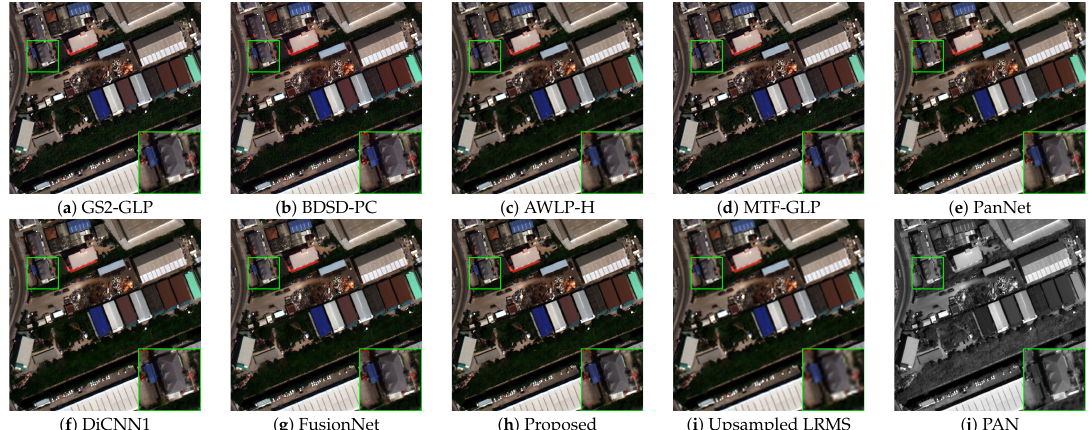
Figure 10. Fusion results of a group of full-resolution samples on the WorldView-3